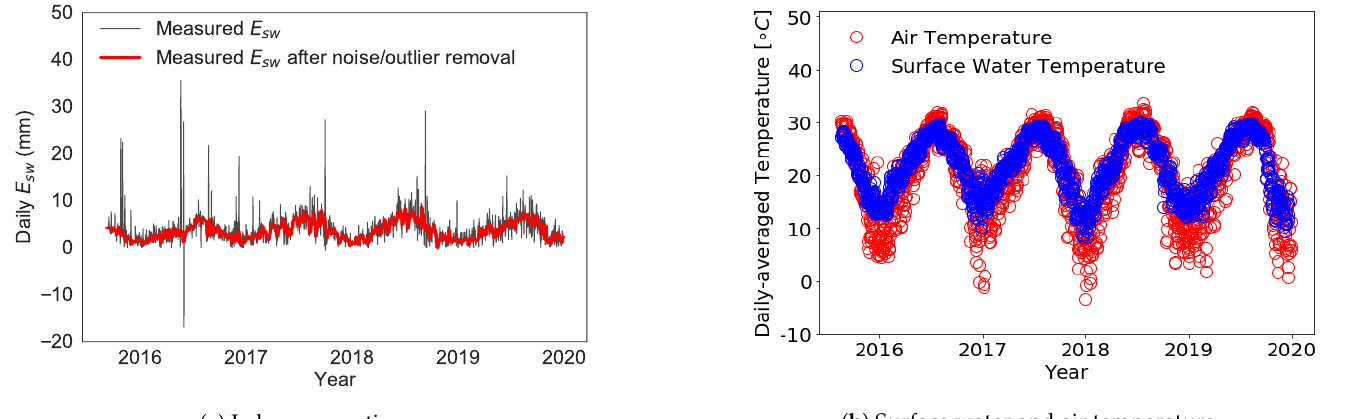
Figure A4. Surface water measurements closest to the NDR weather station. Surface water temperatures at 15-min intervals were obtained from Frio river in Concan, and daily lake evaporation data were obtained from Ingram Lake in